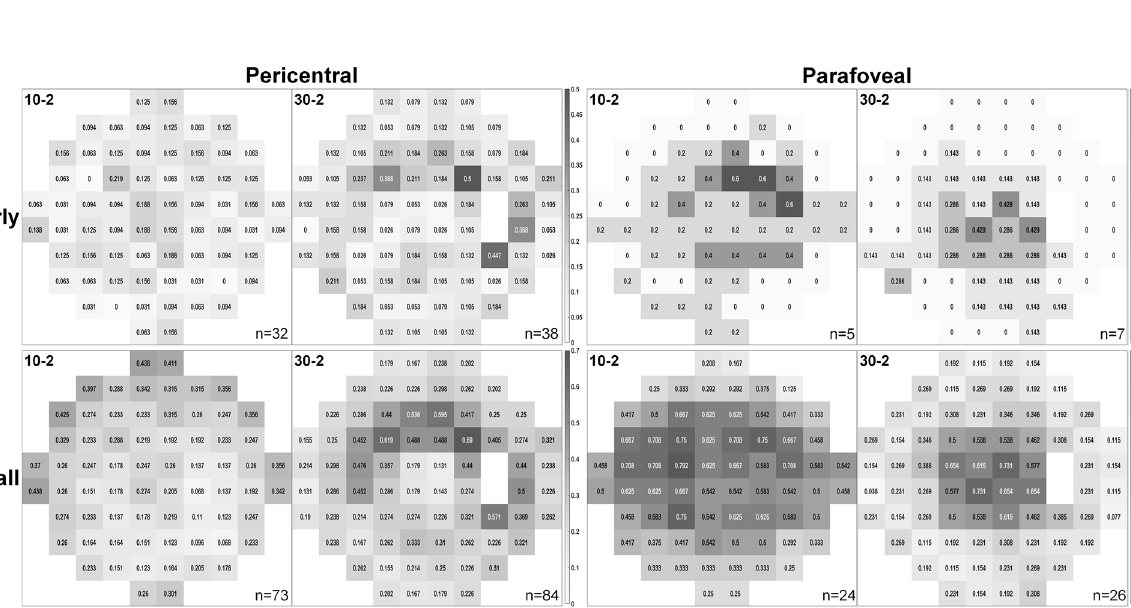
Table 3. Typical patterns of scotoma on the Humphrey 30-2 standard automated perimetry in subgroups according to the pattern among overall patients and those with early retinopathy.